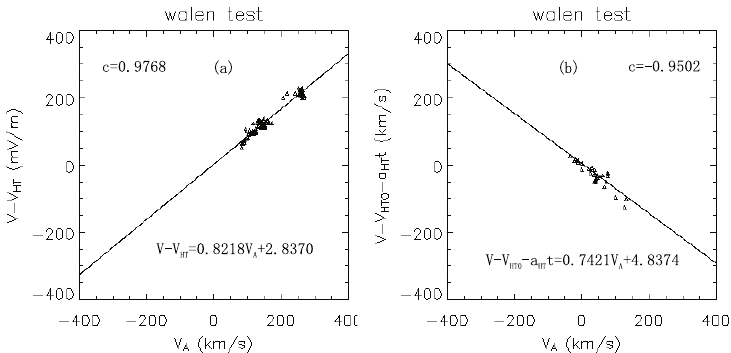
Fig. 5. Wal´en scatter plot for magnetopause crossing on 26